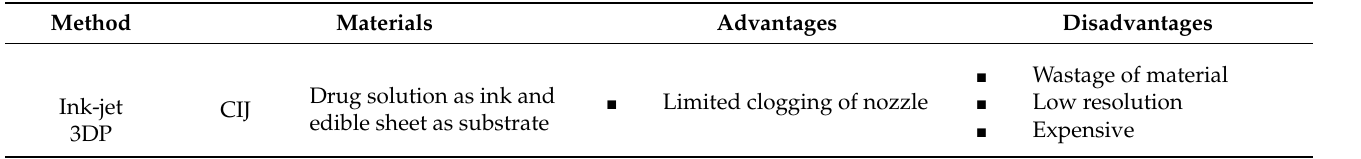
Table 1. Overview on advantages and limitations of the main 3D Printing technologies